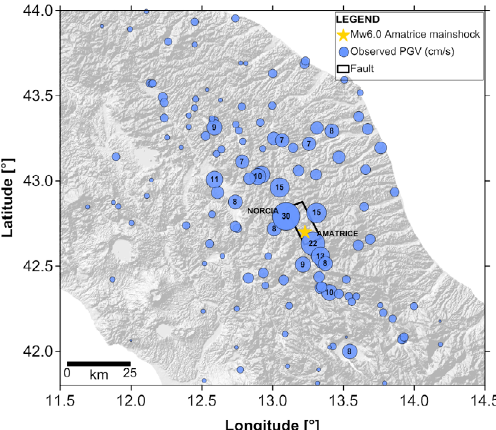
Figure 3 . Spatial distribution of the maximum horizontal Peak Ground Velocity